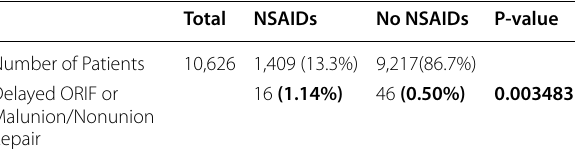
Table 3 Patients with 5 th MT Fractures Initially Managed